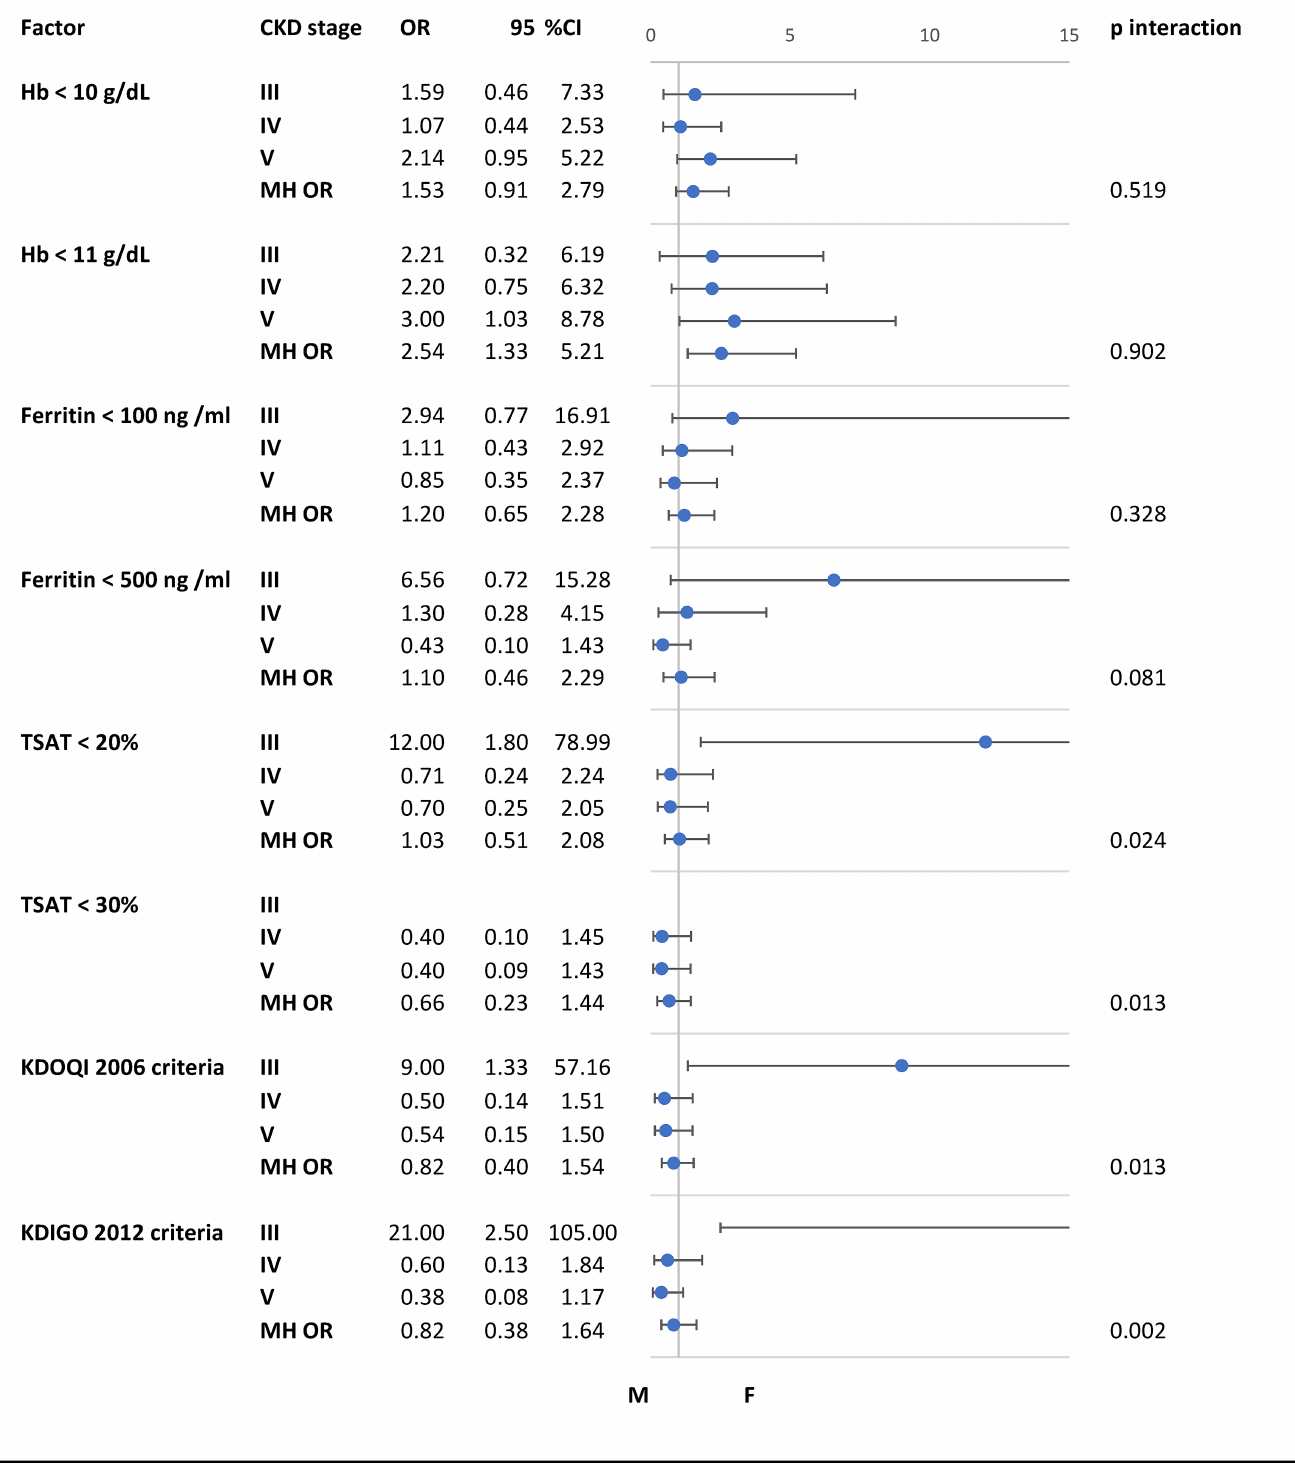
Fig 1. Comparison between men and women across different stages of chronic kidney disease. Abbreviations: Hb, hemoglobin; MH OR, Mantel-Haenszel Common Odds Ratio Estimate; KDOQI 2006 criteria, ferritin < 100 ng/ml and/or TSAT < 20%; KDIGO 2012 criteria, ferritin (cid:20) 500 ng/ml and TSAT (cid:20) 30%.